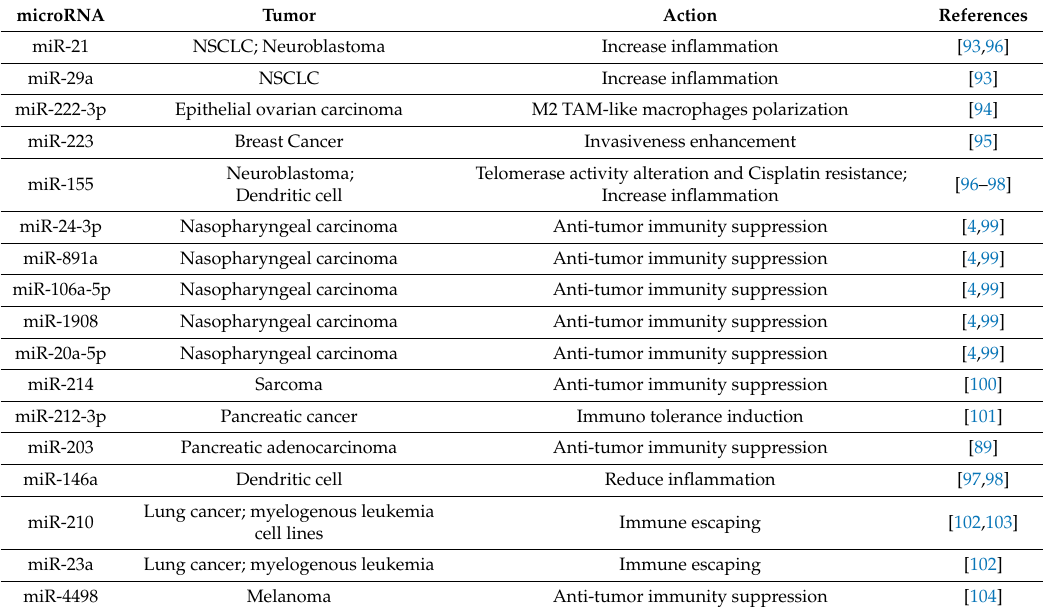
Table 1. Role of miRNAs in immunomodulation and